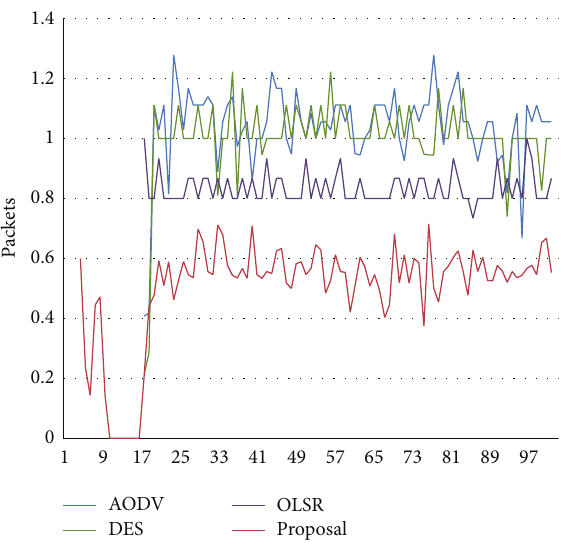
Figure 11: Comparison of reliability factor. Figure 12: Comparison of retransmission attempts.